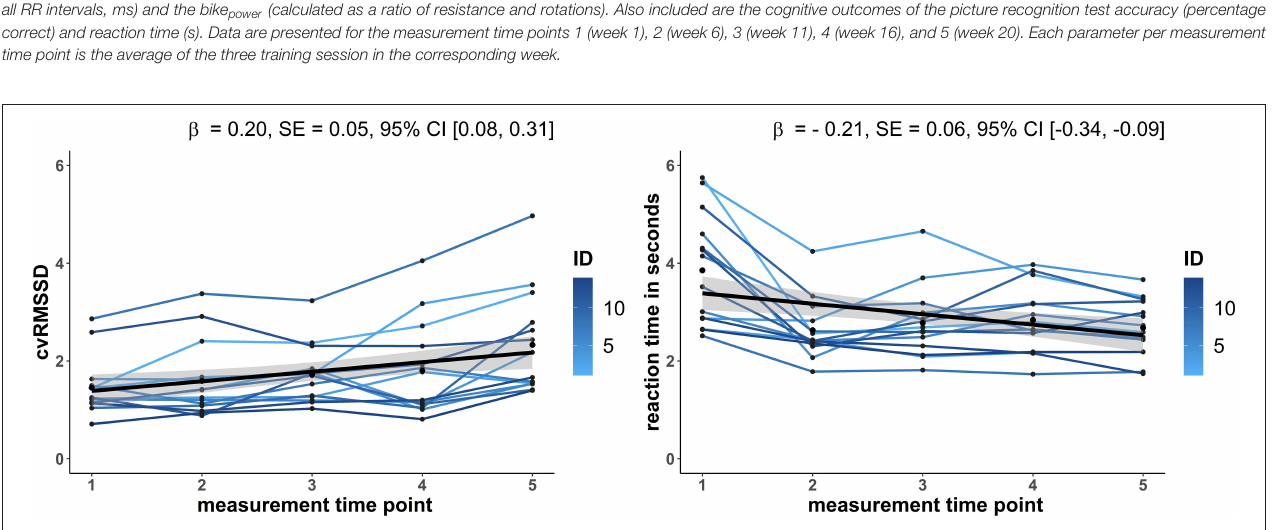
FIGURE 1 | LME results of (A) the vagal mediated HRV index cvRMSSD adjusted for meanRR (coefficient of variation: RMSSD/meanRR *100) and (B) the reaction time in seconds over the five measurement time points 1 (week 1), 2 (week 6), 3 (week 11), 4 (week 16), and 5 (week 20). The trajectories are shown for each subject (colored solid lines, N = 14) and for the estimated group model (black dashed line) with a 95% confidence interval (gray area). Both LME analysis revealed a significant increase, respectively, decrease over the measurement time points. β , beta coefficient of measurement time point effect; SE , standard error; 95%- CI , 95% confidence